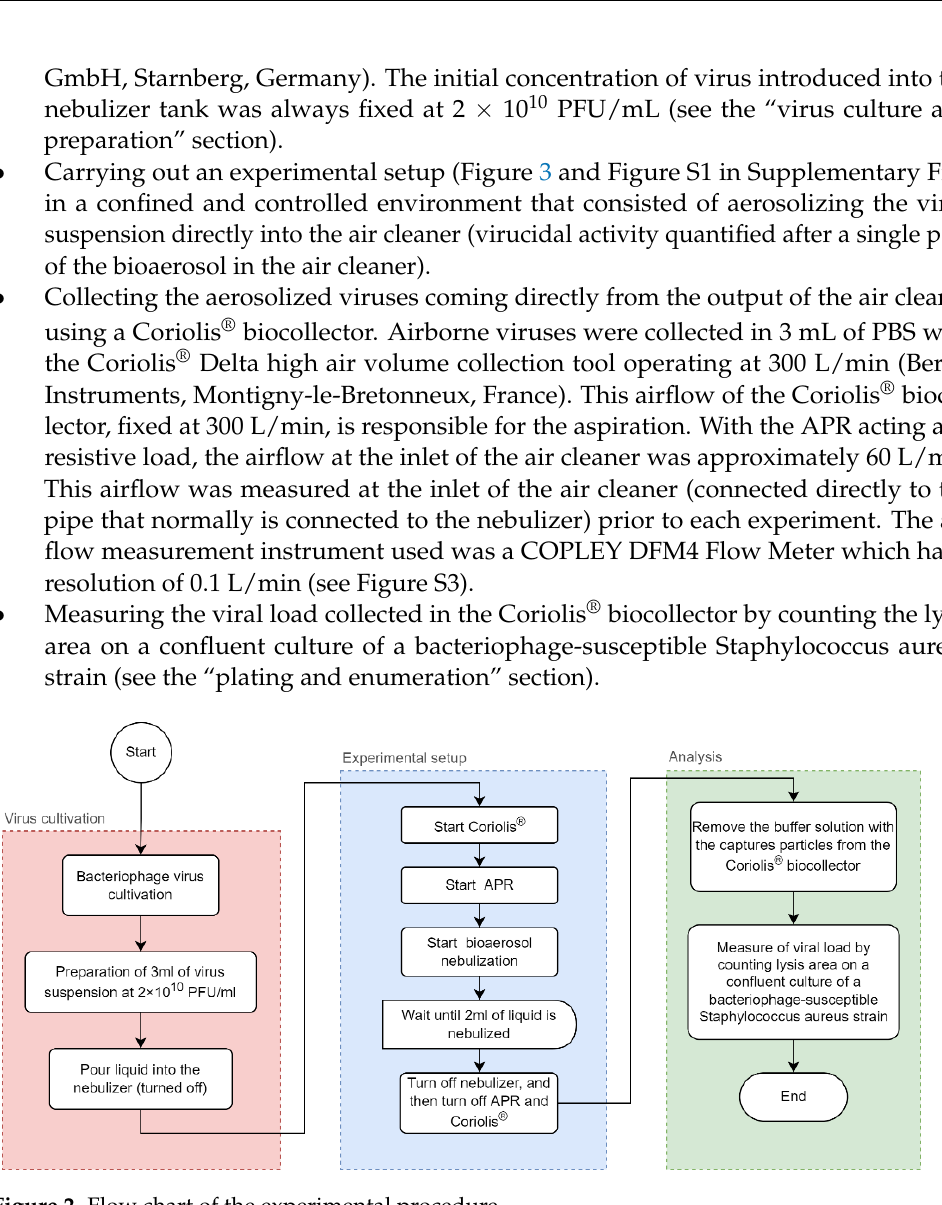
Figure 2. Flow chart of the experimental procedure.